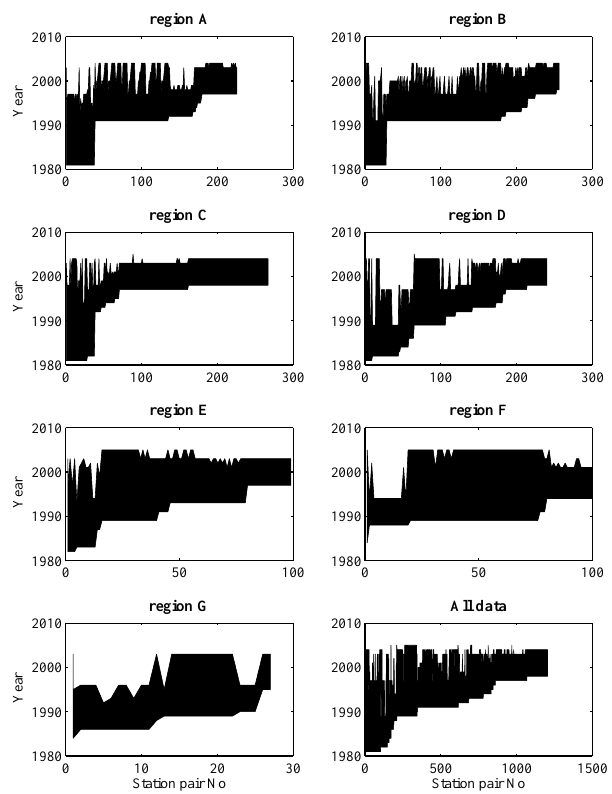
Fig. 1. Distribution of the time span for which the various station pairs were sampled. The different panels shows the different geo- graphical areas (see Fig. 2). The time between the first and second repeat of a station are filled in, sorted by the time of the first